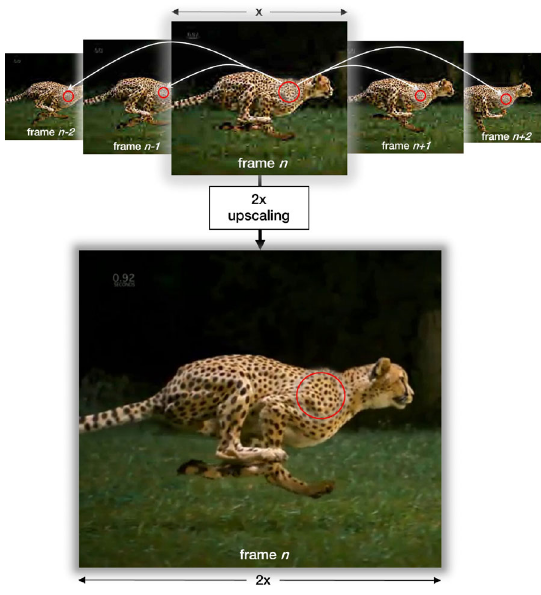
Fig. 1. Deep back-projection networks (DBPNs) [2] Fig. 1 Temporal relationships between adjacent